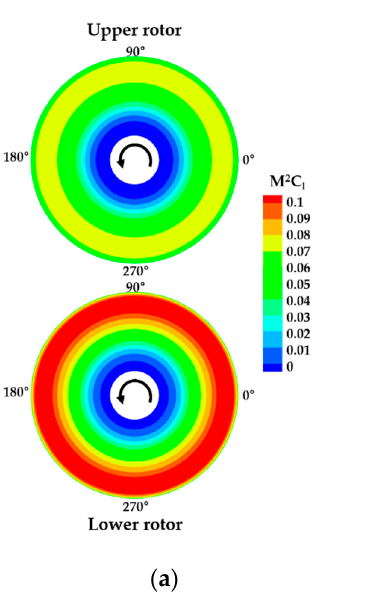
= 0.0102): ( a ) Index T